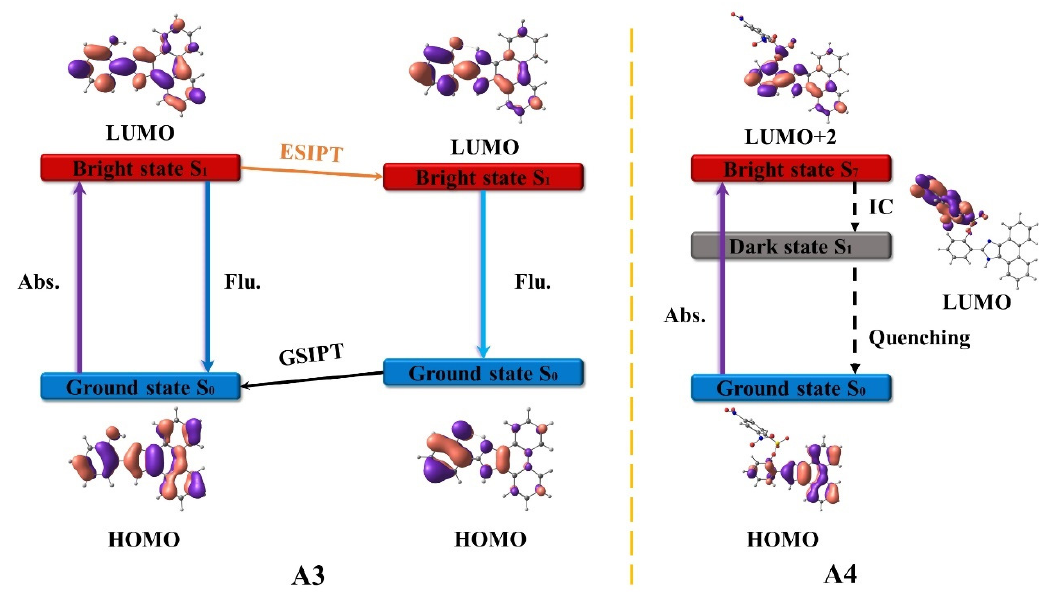
Figure 3. Scheme of the different sensing mechanisms and relevant frontier molecular orbitals A3 and A4.